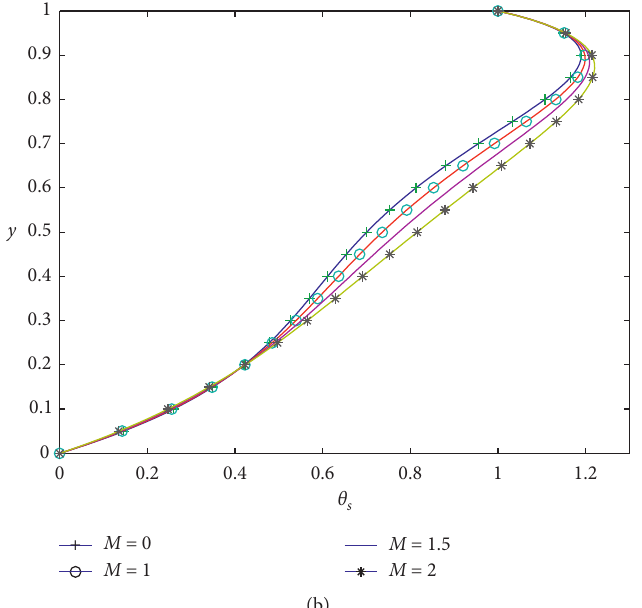
Figure 7: Effect of M on (a) unsteady and (b) steady temperature distributions when t � π /4 , ε � 0 . 01 , H � 3 , β � 2 , Ec � 1 , Q � 0 . 5 , Da � 0 . 1 , φ � 0 . 1 , Re � 1 , Pr � 21 , and Rd � 2.